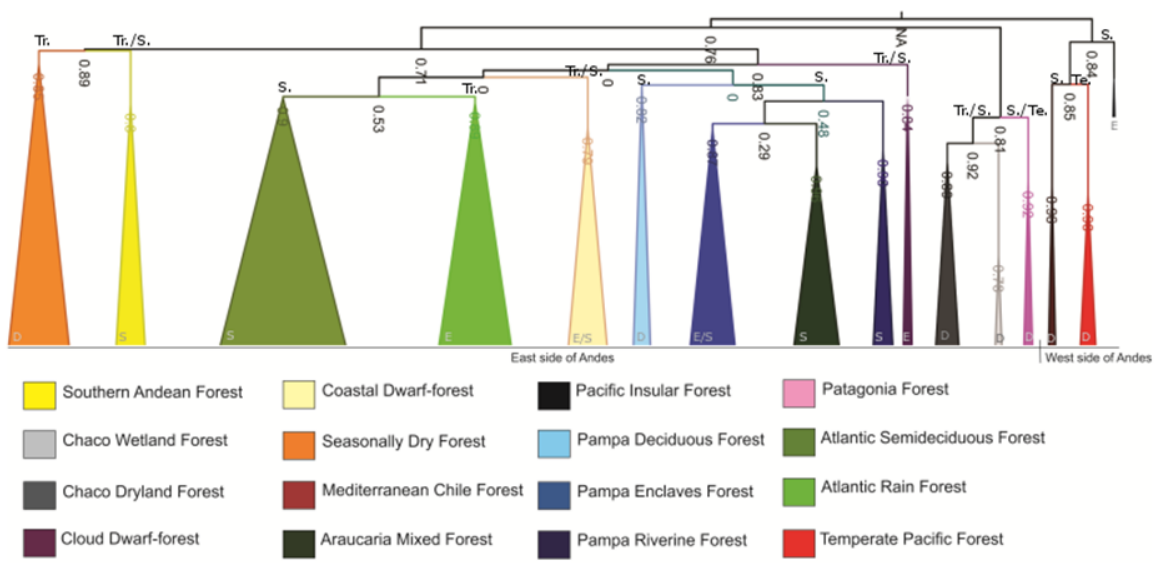
Figure 1. Dendrogram produced by clustering analysis based on a species occurrence matrix used to derive the floris- tic similarity among the 16 vegetation types that occur in southern South America. Tr = Tropical; S = Subtropical; Te = Temperate. D = Deciduous; S = Semideciduous; E = Evergreen.